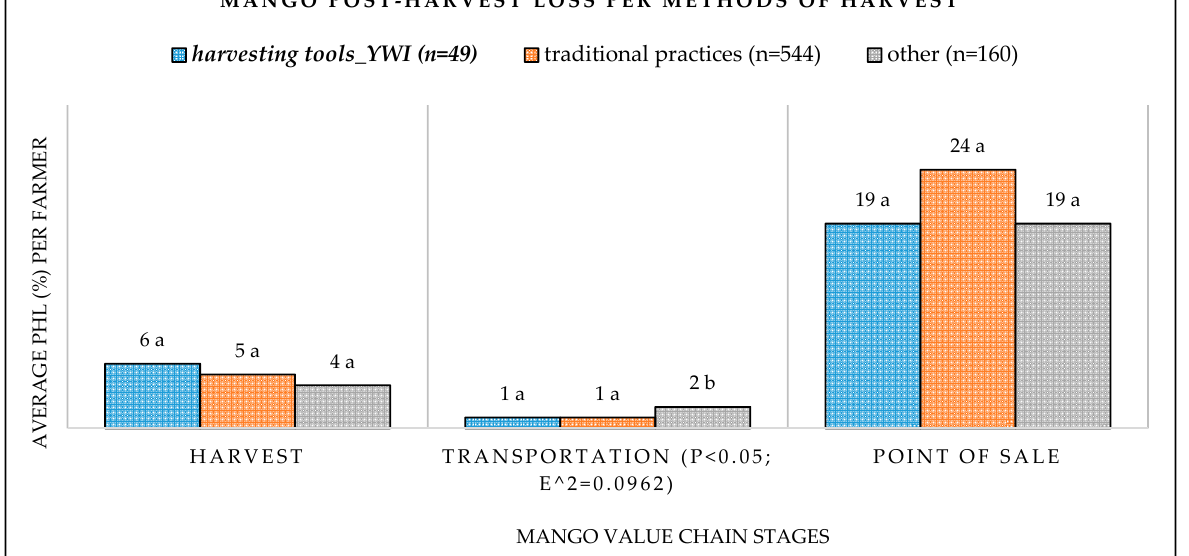
Figure 3. Comparing harvesting tools to traditional methods of harvest. Values with different letters are significantly different at p < 0.05 from the Kruskal–Wallis analysis, Dunn test, and Benjamini–Hochberg adjustment. E^2 = Epsilon- squared value for effect size. YWI refers to the technology that the Yieldwise Initiative promoted. ( n ) refers to the number of farmers who reported using a given practice or technology. ‘Other’ refers to practices that combined both YWI promoted technologies and traditional practices.